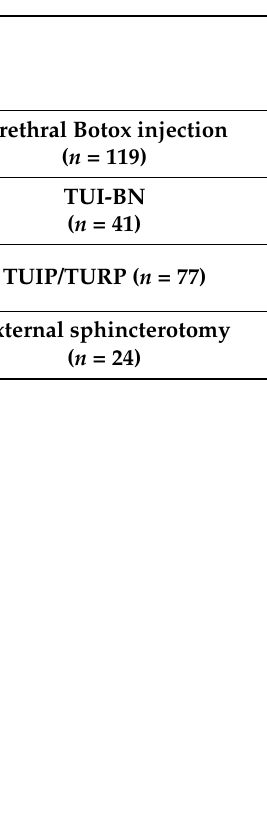
Table 3. Chronic spinal cord injured patients’ satisfaction with bladder management or urological surgeries for spontaneous voiding. The patients had different levels of